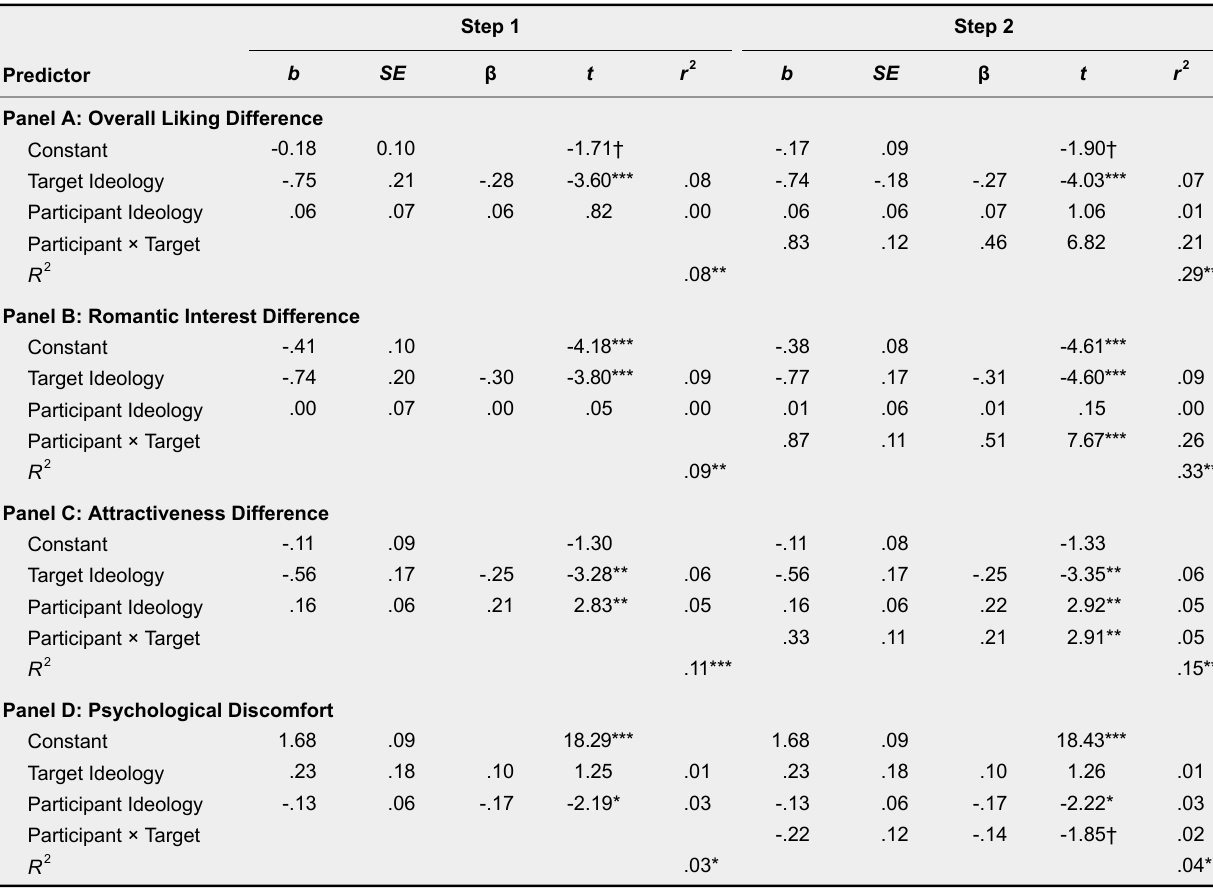
Study 1: Results for Moderated Multiple Regression Analyses for Dependent Variables With Semi-Partial r